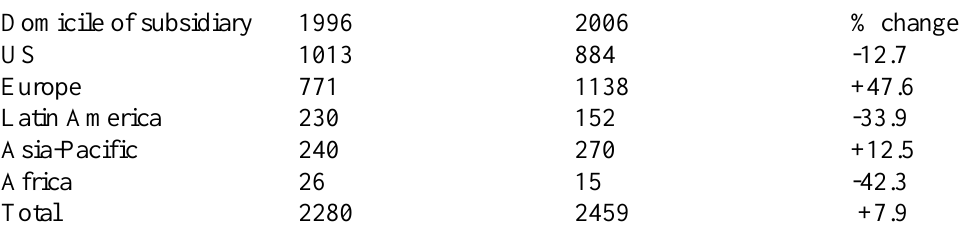
Table 3. Number of C250 Foreign Subsidiaries, Categorized by Host